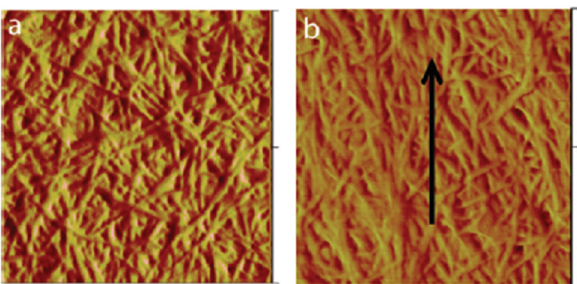
Figure 14: AFM micrographs of surfaces of ( a ) a reference undrawn TEMPO - NFC nanopaper sample ( DR = 1 ) , ( b ) a drawn TEMPO - NFC nanopaper at DR = 1.4. Adapted from ref. [ 75 ]